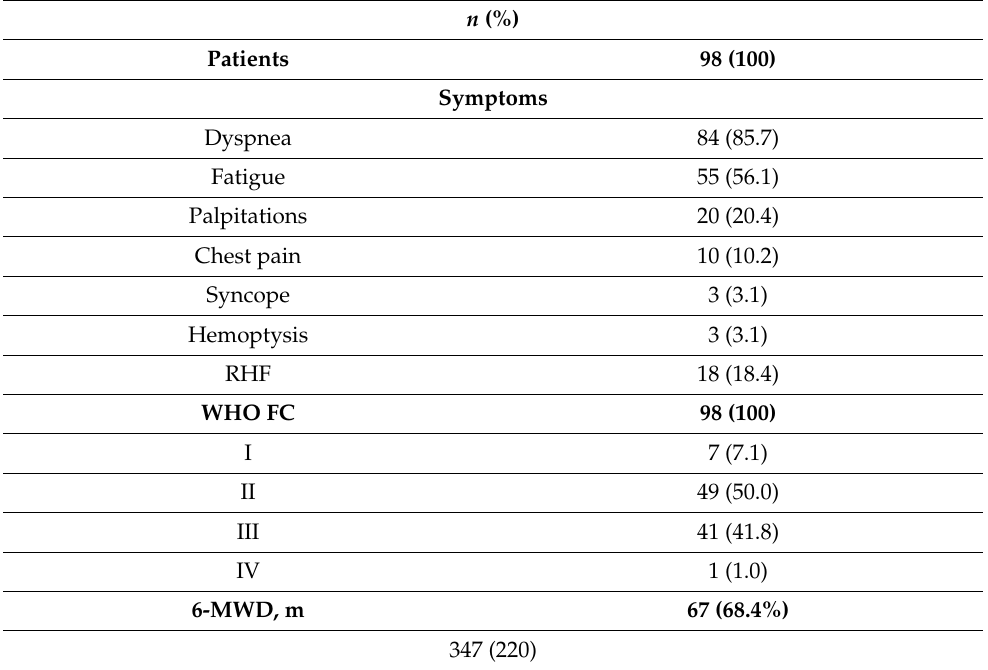
Table 2. Symptoms and Functional Assessment.